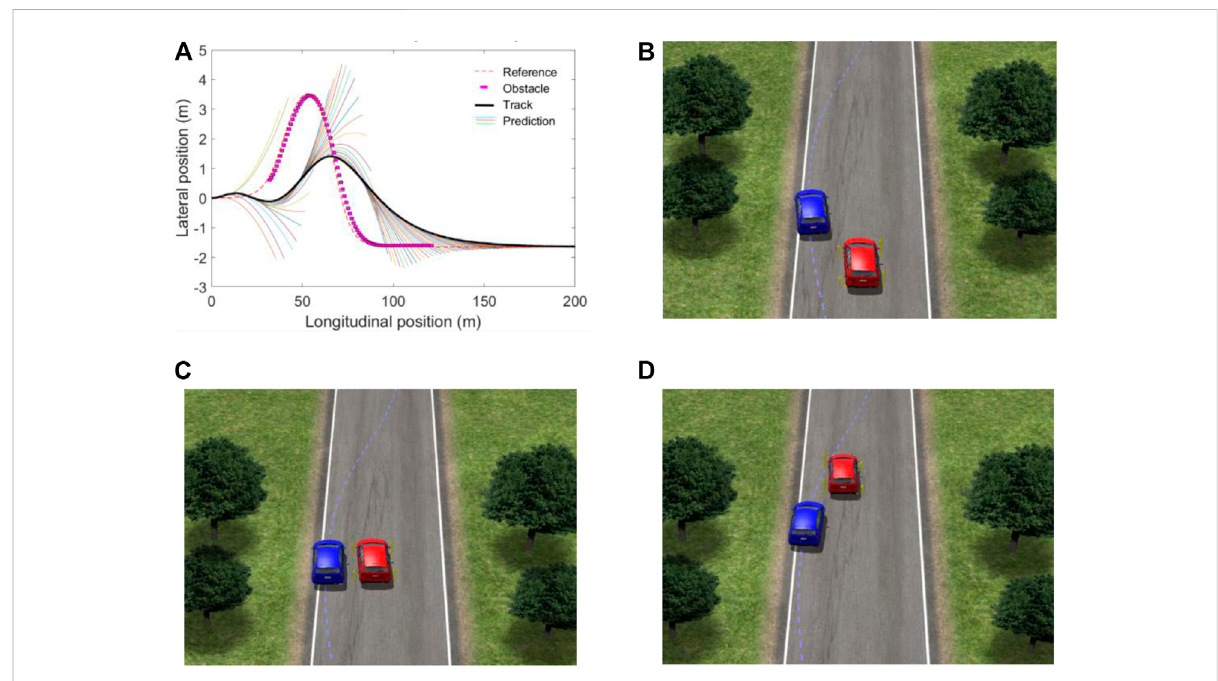
FIGURE 6 Obstacle avoidance trajectory and obstacle avoidance model at 82 km/h. (A) obstacle avoidance trajectory; (B) model before obstacle avoidance; (C) model during obstacle avoidance; (D) model after obstacle